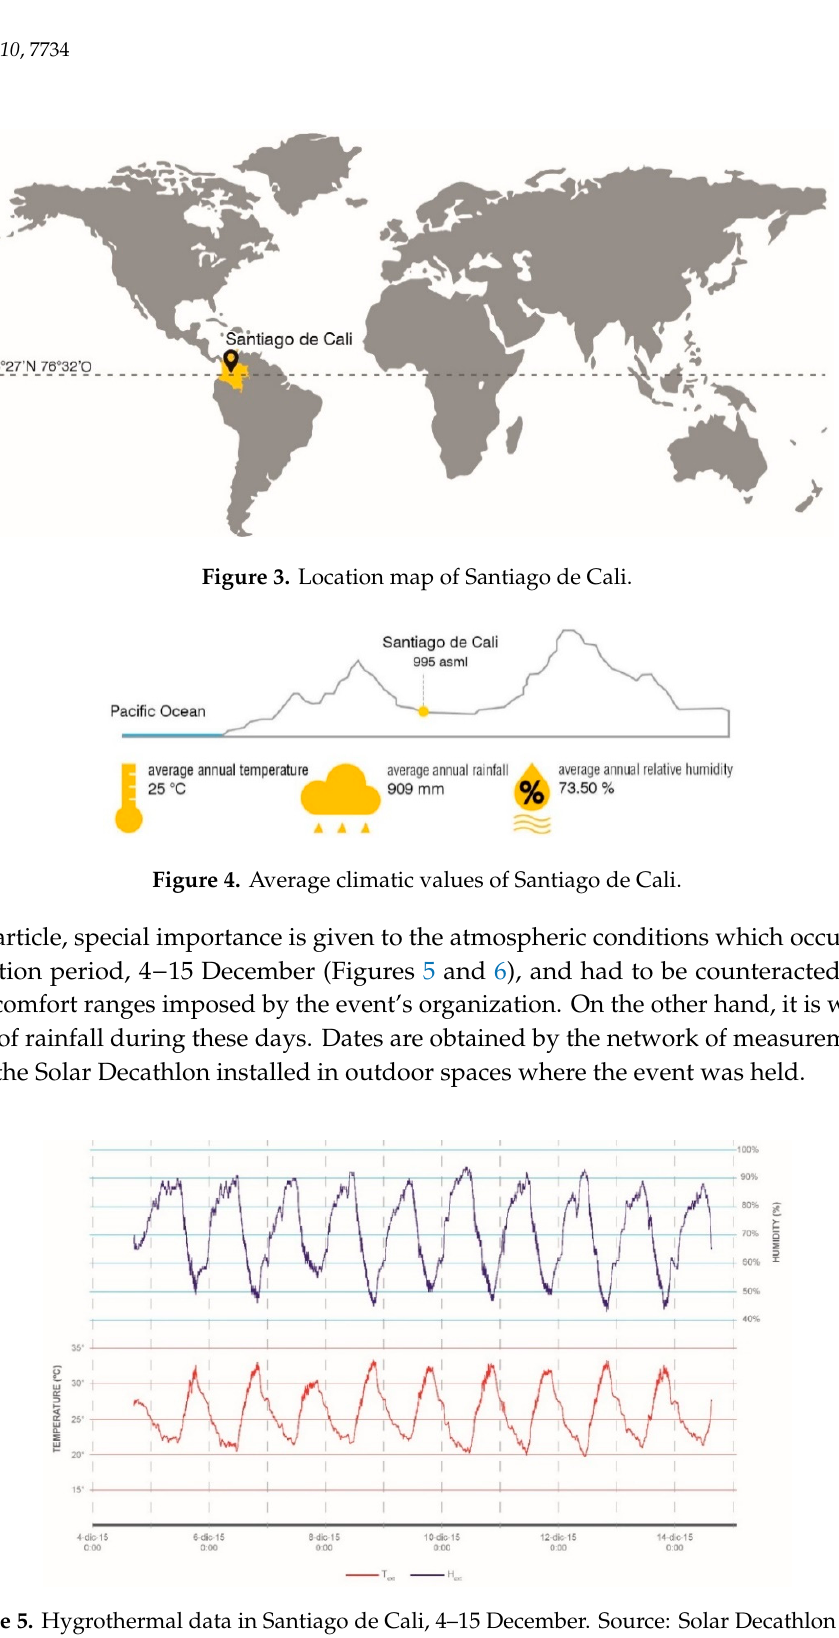
Figure 6. Lighting data in Santiago de Cali, December 4 − 15. Source: Solar Decathlon staff. 3. Case Study: AURA Project The development of AURA Project [35] aims to unite both ends of the Latin American reality: the American and the Southern European. They are both sides of the same coin, not only in architecture but also in lifestyle; they both inhabit what could be called the “architecture of warm countries” [36]. Social housing generally has two weaknesses: Firstly, when it is built as a low-cost house, frequently the comfort conditions do not reach the minimum levels, this is due to a low quality design where there is a reduction of the spaces, or by the use of low quality materials, by the bad quality of the carpentry, little efficient isolations, etc. However, we have to add that the inhabitants of these houses are people and families in a situation of economic vulnerability, so that in most cases they cannot use air conditioning equipment to alleviate the bad conditions of comfort because they cannot face the economic outlay that this implies, we are talking about energy poverty. Therefore, when we talk about sustainable social housing, we refer to an architecture where the maximum comfort of the inhabitants is sought with the least possible energy consumption, that is, that the house itself is placed as much as possible within the comfort range, which is what we have quantified in this publication. When this is not possible, it is necessary to make use of air conditioning technology. Therefore, this paper argues that air conditioning equipment should be an integrated part of social housing, always focused on the energy self-supply of the home and aimed at alleviating peak atmospheric situations where passive strategies are not able to generate minimum comfort conditions.